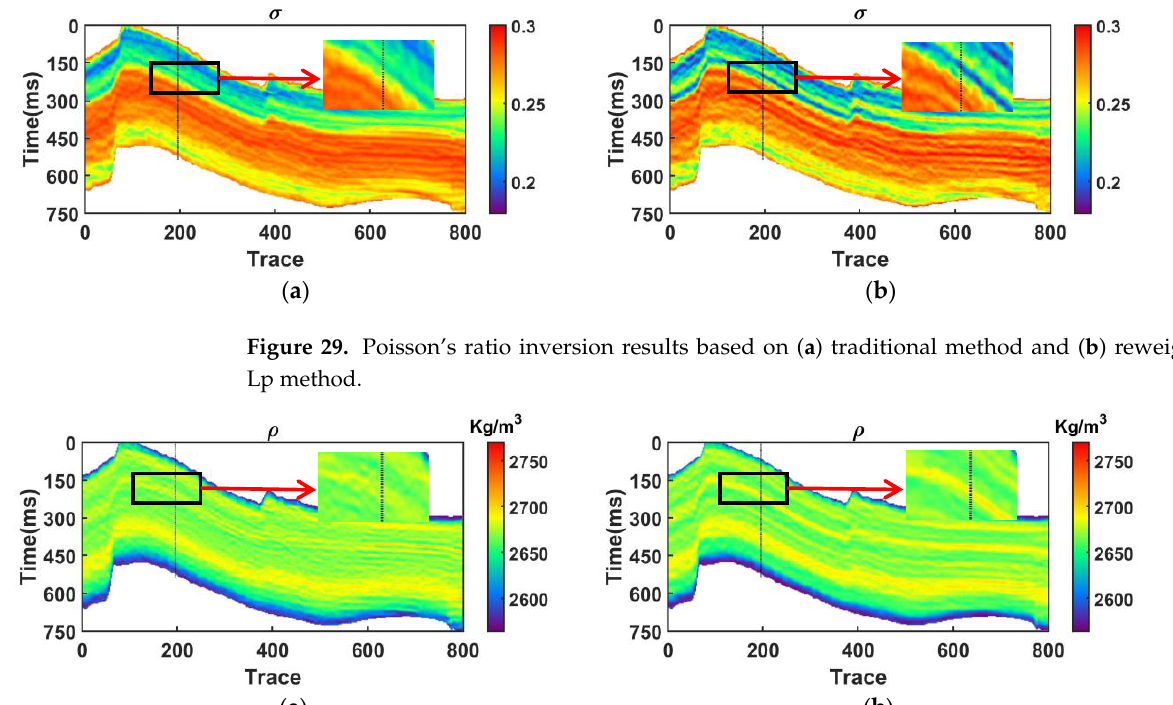
. Figure 32. Absolute error comparison of the inversion results. 4. Conclusions In this research, we proposed a direct inversion method for brittleness parameters based on a reweighted Lp-norm. The regularization constraint in this method could re- duce the number of multiple solutions to the inversion problem and could improve inver- sion stability. The reweighted Lp method effectively restored the sparsity of the inversion results and improved inversion accuracy by constraining the regularization term. In ad- dition, the inversion framework established by the ADMM method improved the conver- gence speed. The method was validated by theoretical models and field data. The inversion results expressed that the reweighted Lp method could reduce the inversion error, improve the vertical resolution, enhance the lateral continuity, and describe the reservoir information more accurately. The proposed methodology can be applied in different contexts, both in